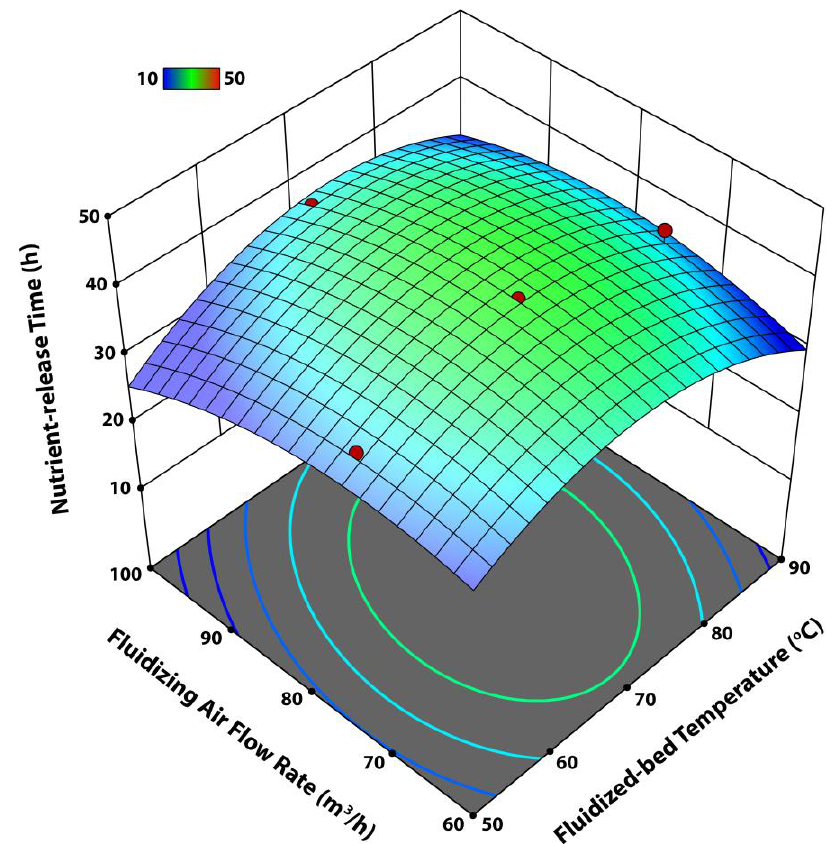
Figure 9. Interactive effect of the fluidizing air flow rate ( Q air ) and fluidized-bed temperature ( T fb ) on the nutrient-release time.